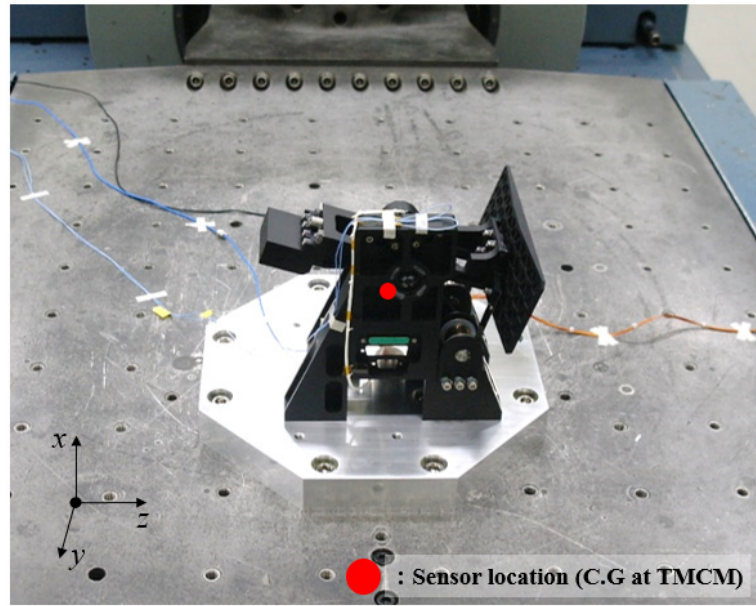
Figure 7. Launch environment test set ‐ up of TMCM.